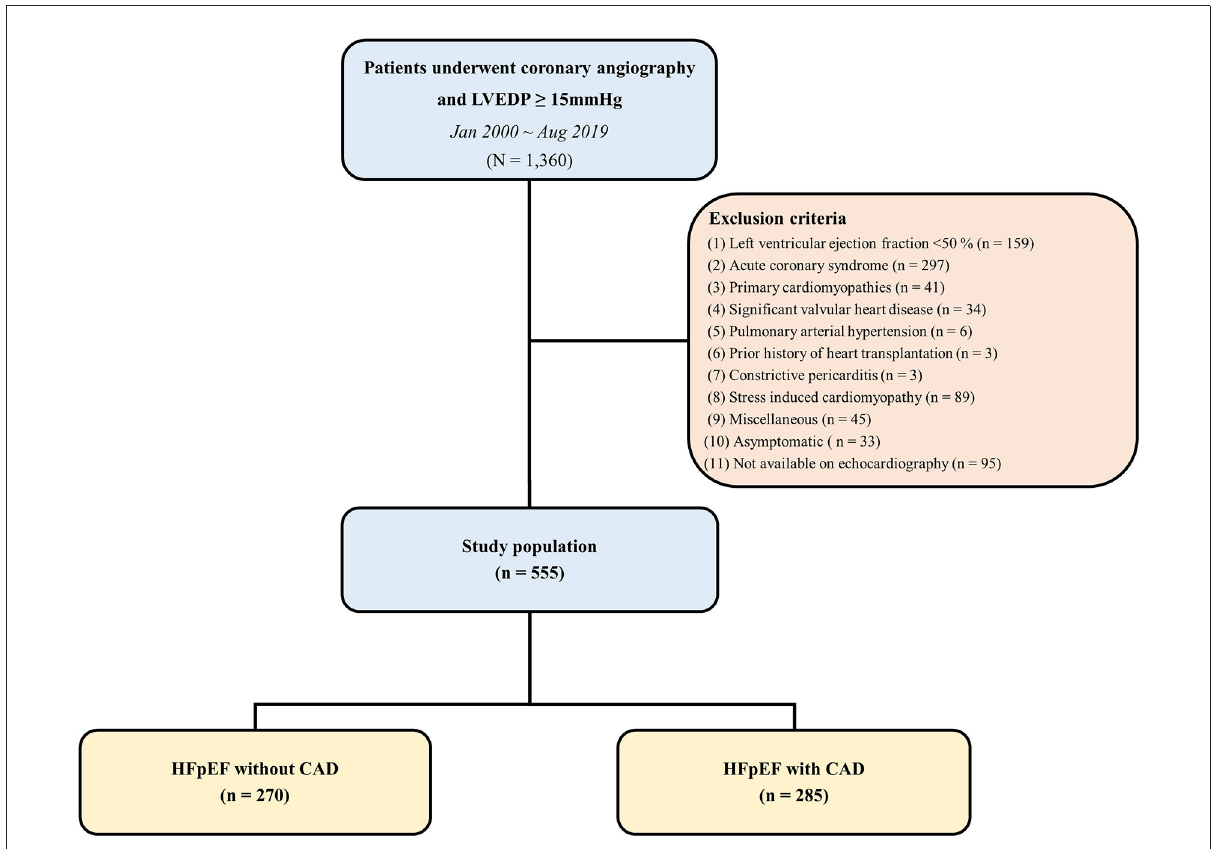
FIGURE1 Flow diagram. CAD, coronary artery disease; HFpEF, heart failure with preserved ejection fraction; LVEDP, left ventricular end diastolic